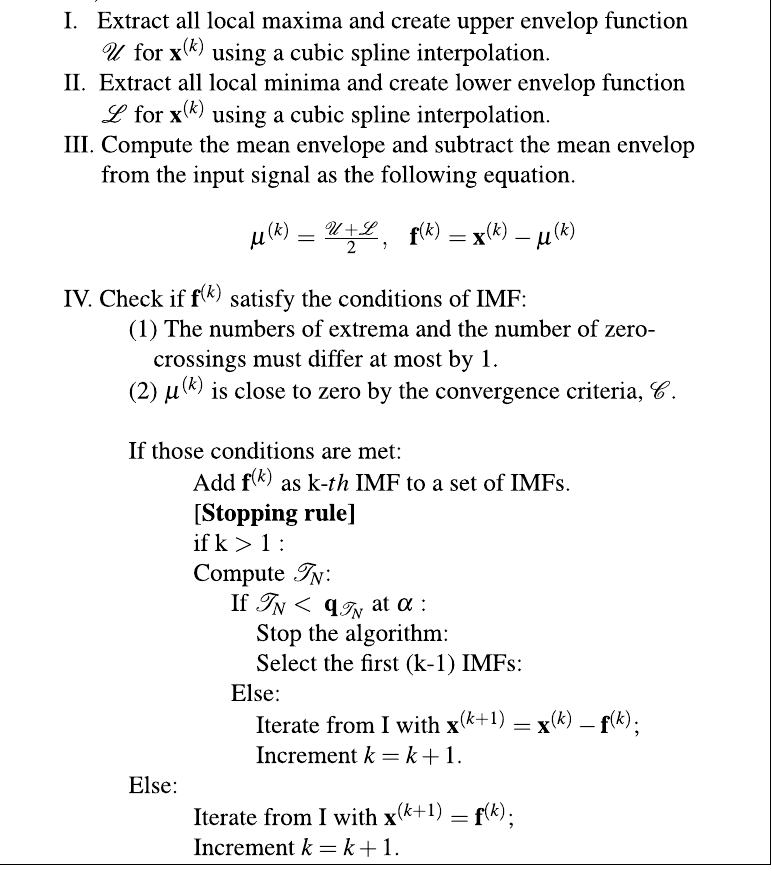
Table 1. The modified EMD algorithm.